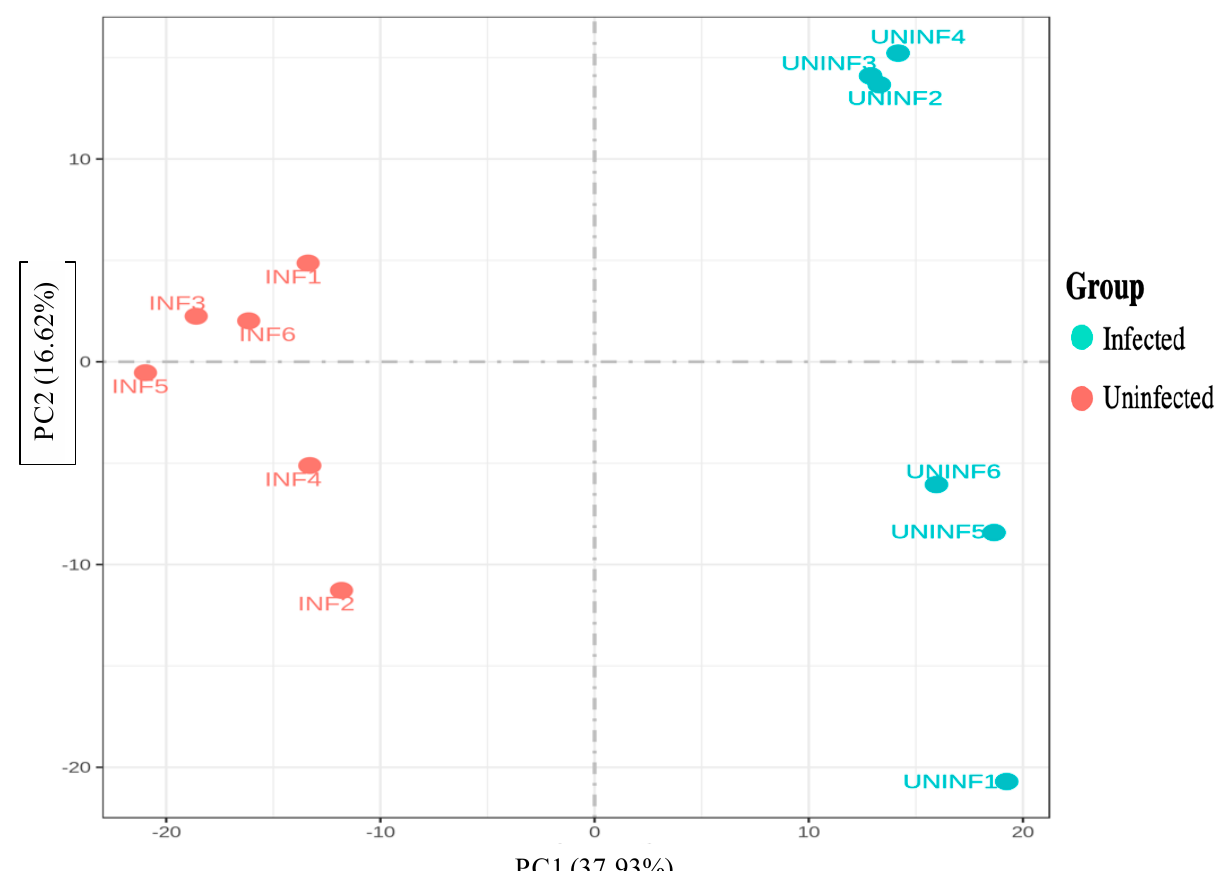
Figure 3. Principal component analysis. The very different expression levels between the infected and uninfected statuses are reflected on the PC1 axis. The PC2 axis reflects that variation among uninfected colony level expression is relatively wide, whereas variation in colonies infected with SINV-3 is much narrower.